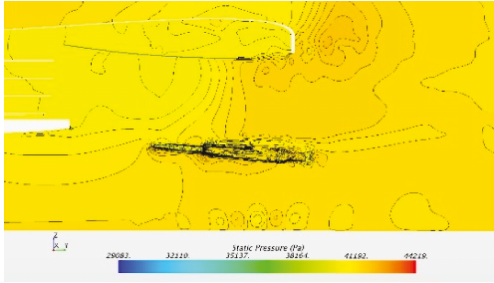
Figure 18: Flow fi eld pressure contour at 0.8s.